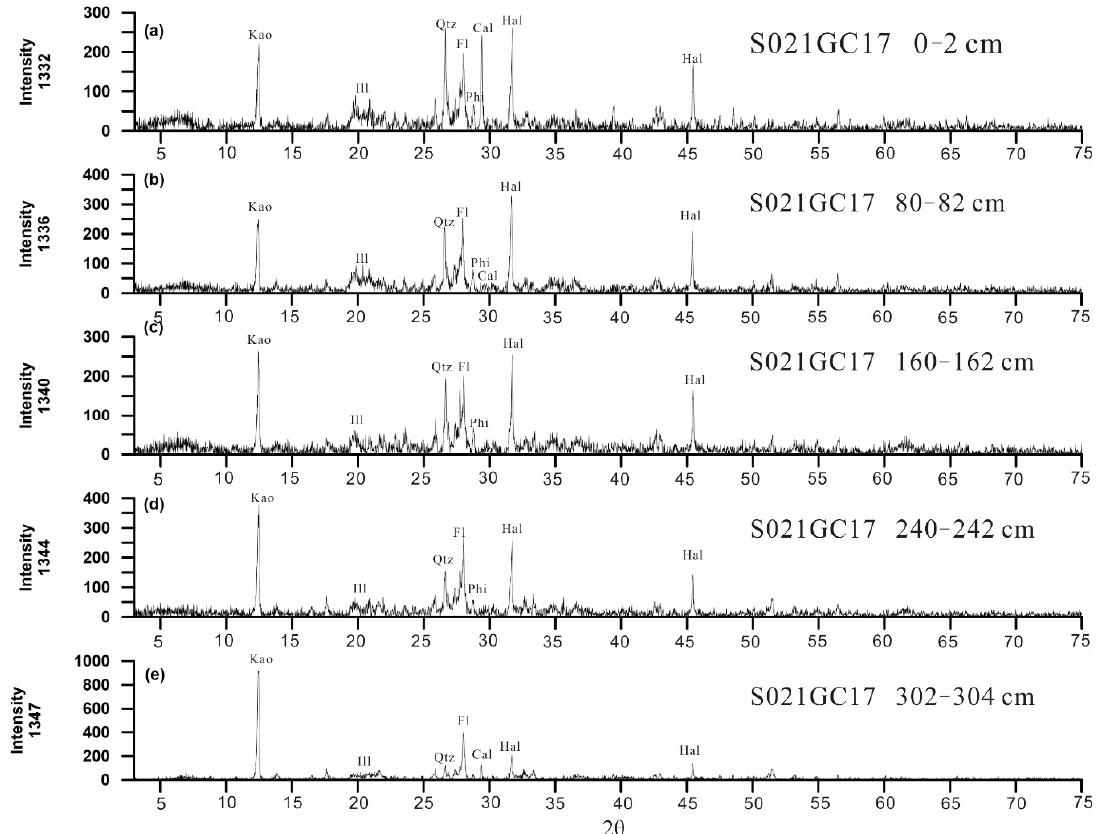
Figure 3. a – e. X-ray powder diffraction patterns of bulk sediment samples from different depths. Kao = kaolinite; Ill = illite; Phi = phillipsite; Qtz = quartz; Fl = feldspar; Cal = calcite; Hal = halite.